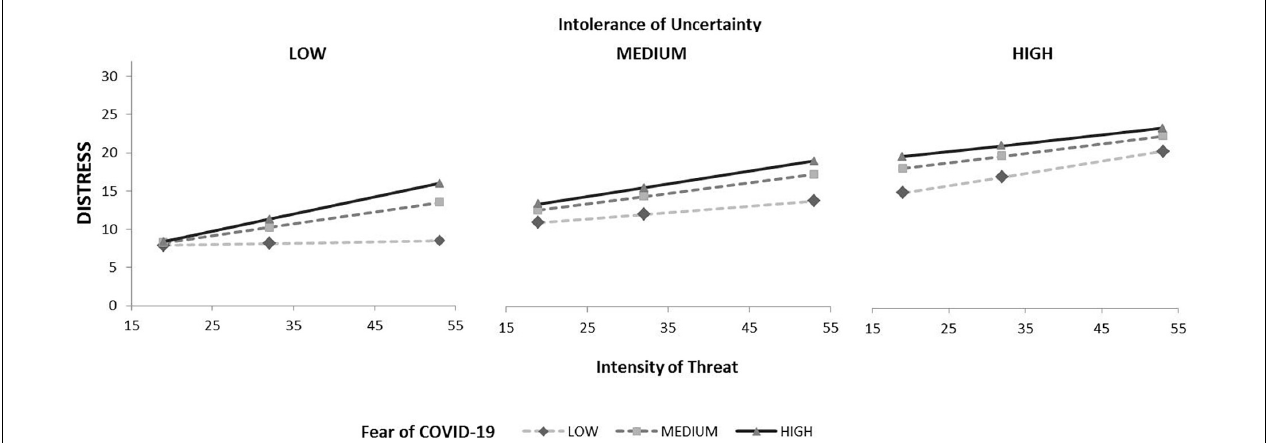
FIGURE 2 | Interaction of intolerance of uncertainty, fear of COVID-19 and intensity of treat affect distress score.